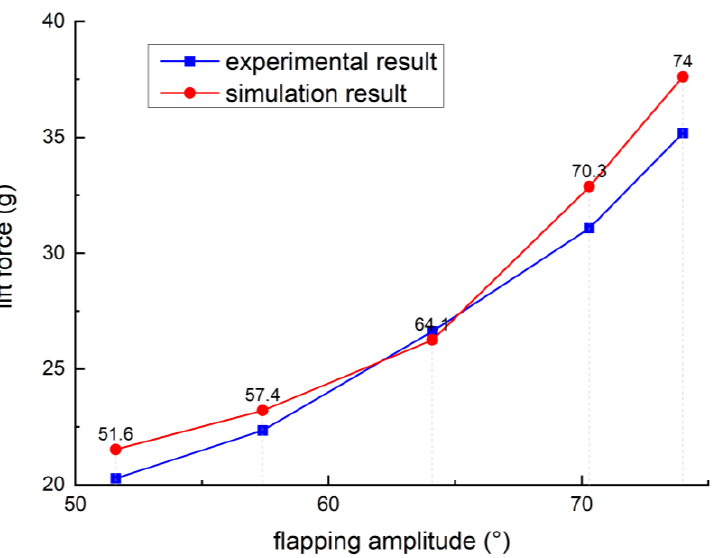
Figure 24. The flapping amplitude-lift force of the experiment and CFD results with different flapping amplitudes.